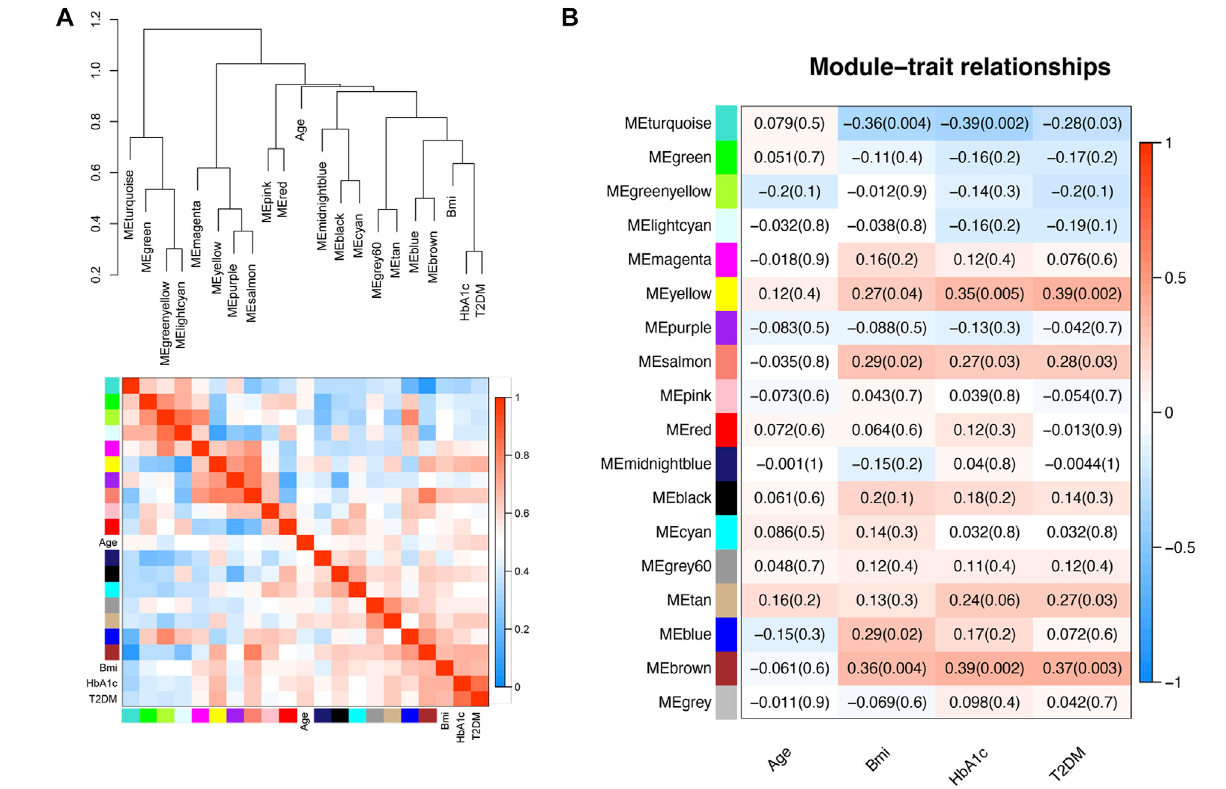
FIGURE2| Relationshipsbetweenthemodulesandclinicalcharacteristics. (A) HierarchicalclusteringdendrogramofMEs(markedwithcorrespondingcolors)and clinical characteristics. In the heatmap, red indicates high adjacency (positive correlation), and blue indicates low adjacency (negative correlation). (B) Module-trait relationships. Each column corresponds to a clinical trait, and each row corresponds to an ME. The numbers in the rectangles are the correlation coef fi cient and the p -value. Red indicates a positive correlation, and blue indicates a negative correlation.